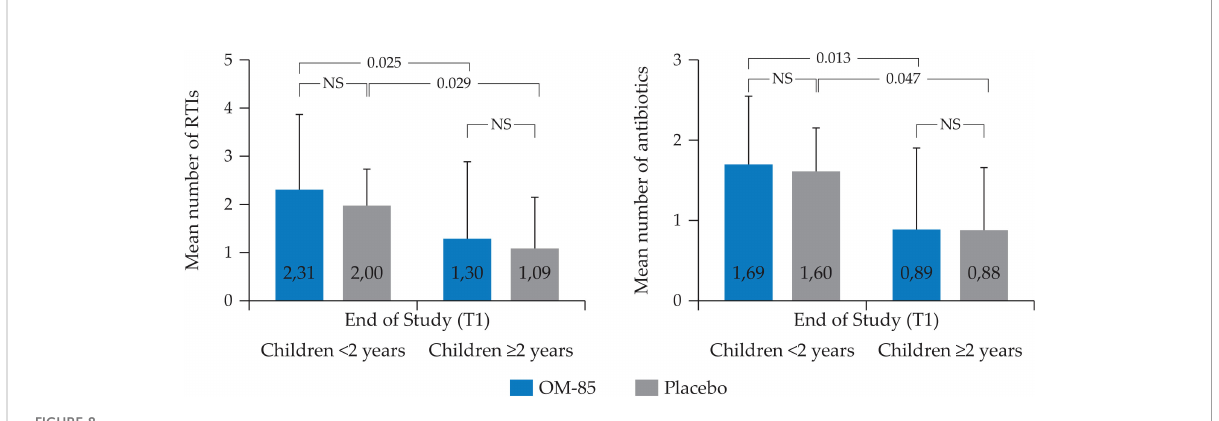
FIGURE 8 Mean number of RTIs and antibiotics used during the study and recorded at T1 in the children (n=98), <2 (n=18) and ≥ 2 (n=80) years of age (Mann U Whitney test). RTIs = LRTIs, URTIs, AOM, and otorrhea. URTIs: upper respiratory tract infections, LRTIs, lower respiratory tract infection; AOM, acute otitis media; NS, not signi fi